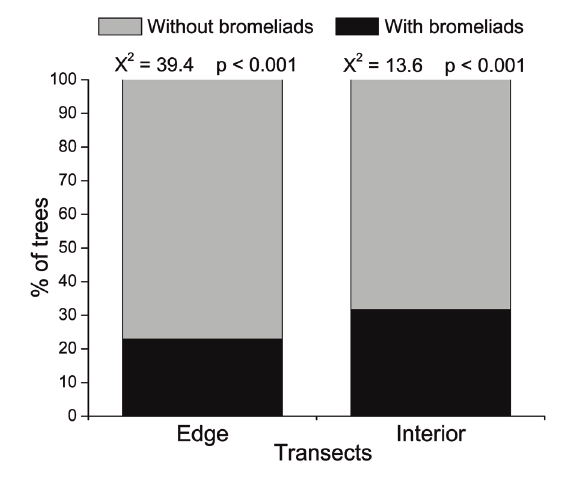
Figure 2 - Proportion of trees without and with bromeliads in the edge and interior transects of Itapanhaú mangrove. Chi- square results.